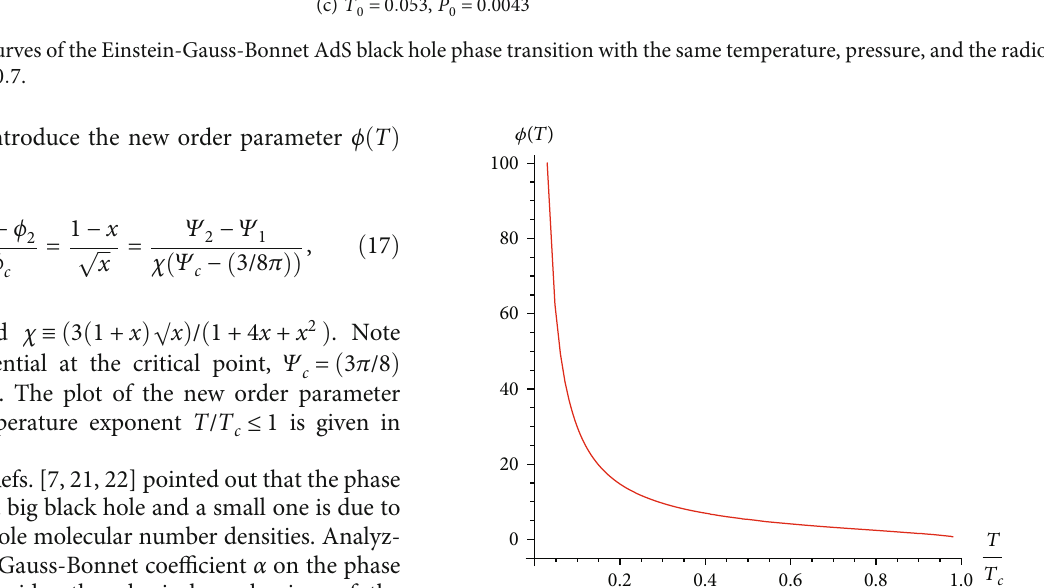
curve of the Einstein-Gauss-Bonnet AdS c c